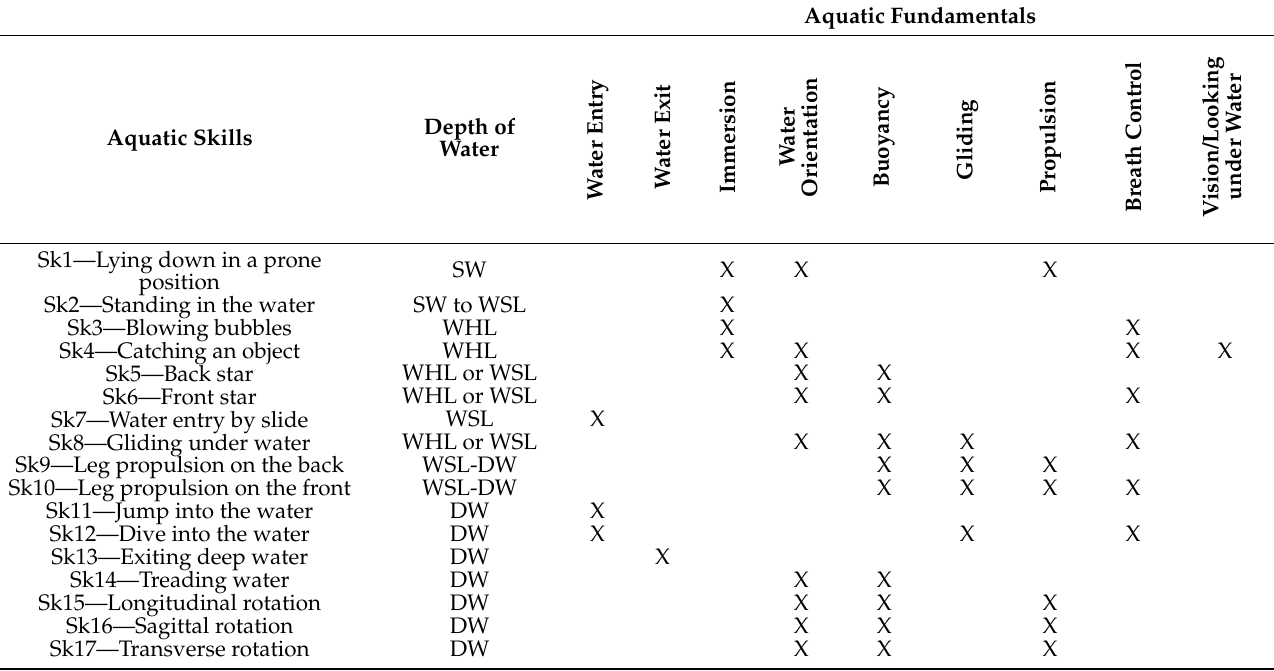
Table 1. Aquatic fundamentals measured by the PSPWC.